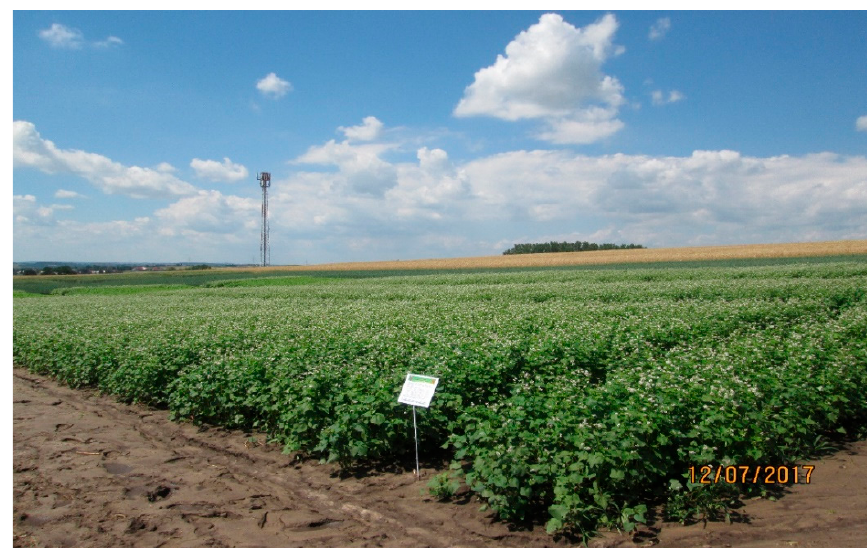
Figure A2. The experiment with the common buckwheat (BBCH 15) .